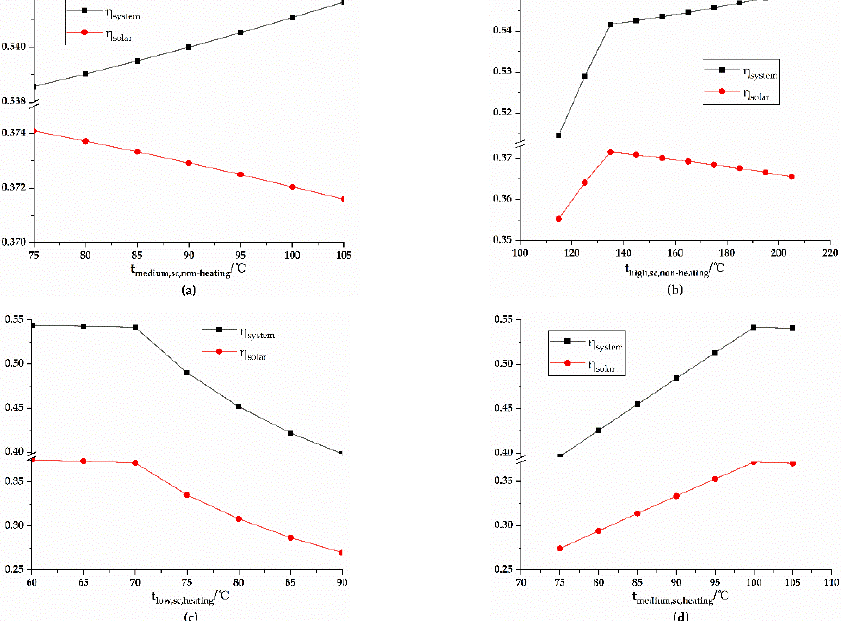
Figure 16. Variations in the performance of the system full year. (( a – d ) denote four different variables on the horizontal axis.)